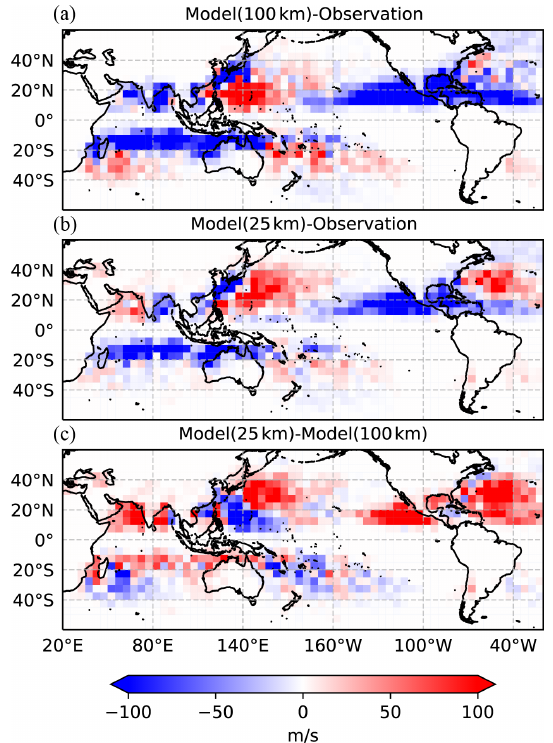
Figure 3. Global maximum sustained wind anomalies of the trop- ical cyclones (units: ms − 1 ). The track density is analyzed in (5 ◦ × 5 ◦ ) equidistant grid boxes at 6h intervals. (a) Maximum sus- tained wind anomalies between FGOALS-f3-L and IBTrACS; (b) maximum sustained wind anomalies between FGOALS-f3-H and IBTrACS; and (c) maximum sustained wind anomalies between FGOALS-f3-H and